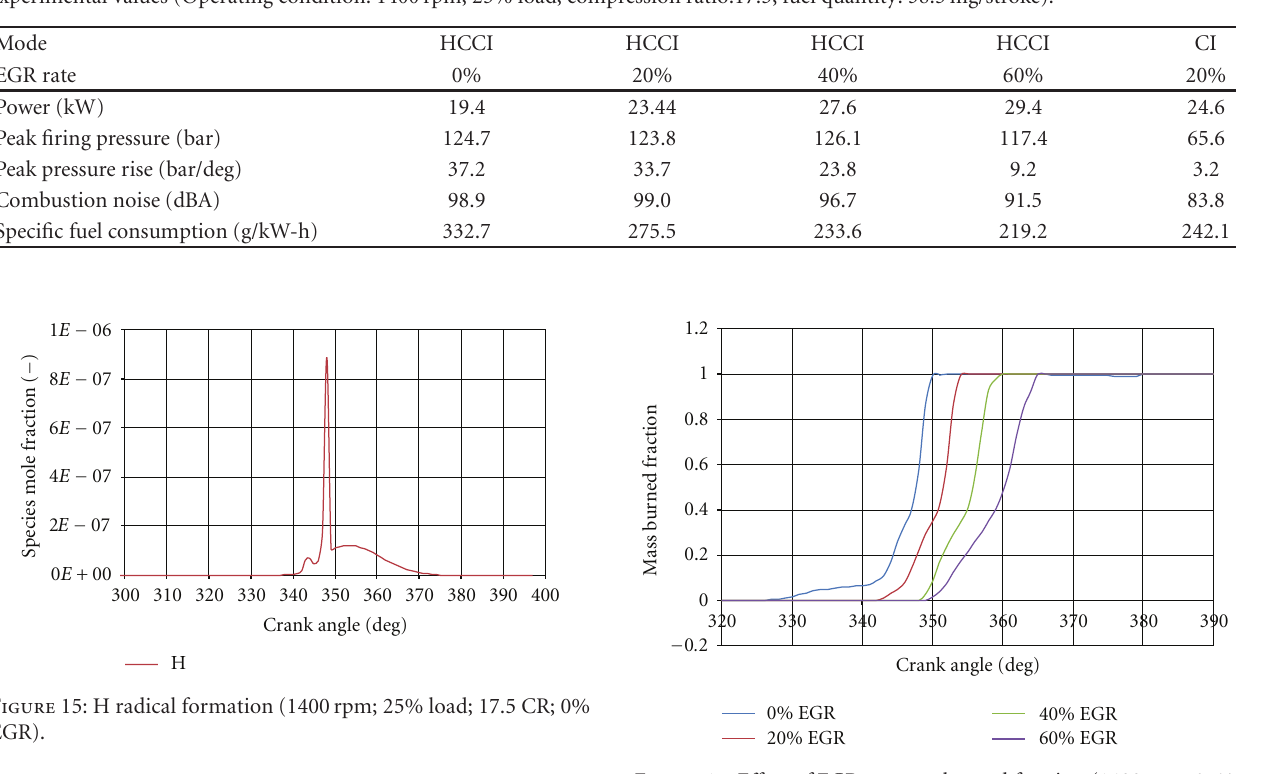
Table 3: Performance parameters of HCCI mode simulation results with varying EGR condition and comparison with CI mode